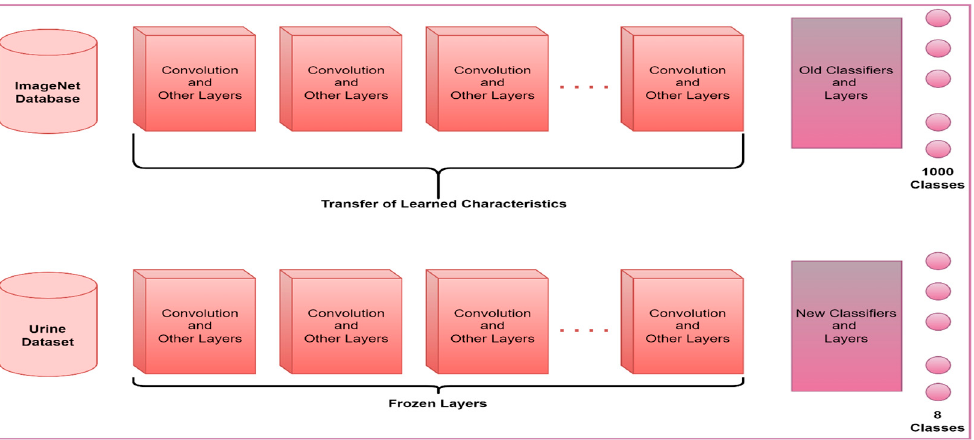
Figure 4. Layer update on pre-trained models. Table 2. Accuracy values of pre-trained models (%).